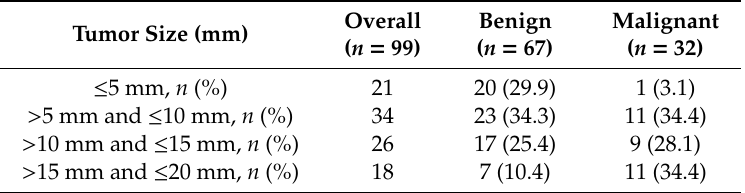
Figure 1. Bar graph illustrating the association between preoperative ultrasonographic results for lesion size and postoperative histopathological results for benign versus malignant tumors. Data represent mean ± SD . Table 3. Testicular tumors stratified by tumor size.